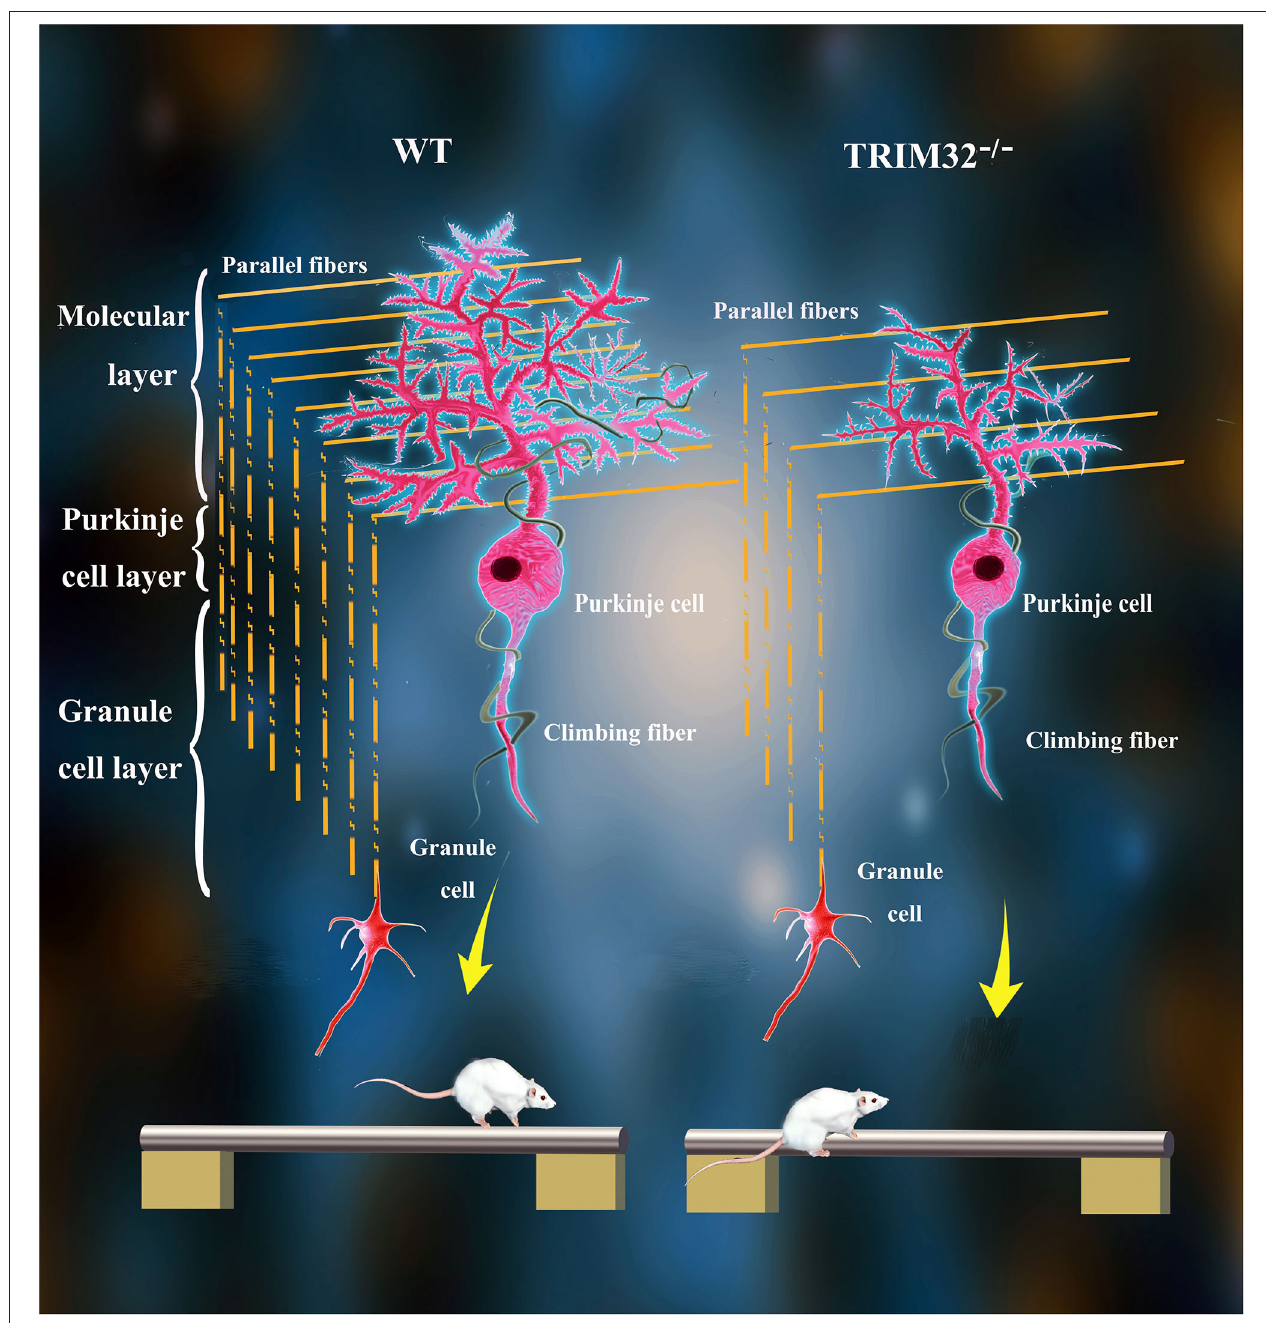
FIGURE 8 | Schematic summary of proposed pathological changes underlying cerebellar motor dysfunction in TRIM32 − / –